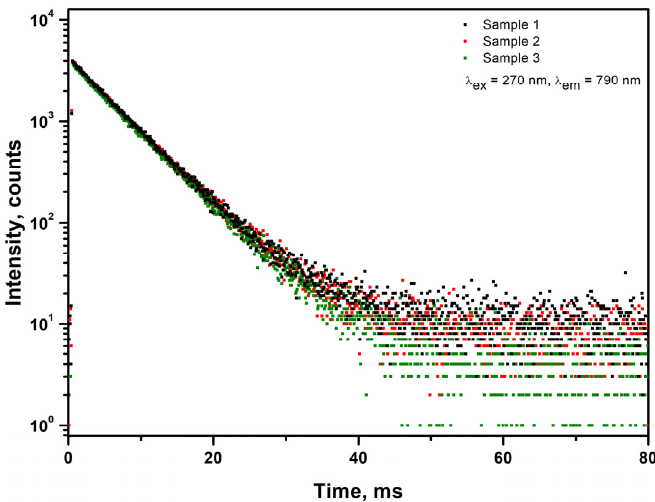
Figure 6. Decay curves of the Cr 3+ emission of the GAGG:Ce,Cr,Mg,Ca powder samples upon 270 nm excitation.